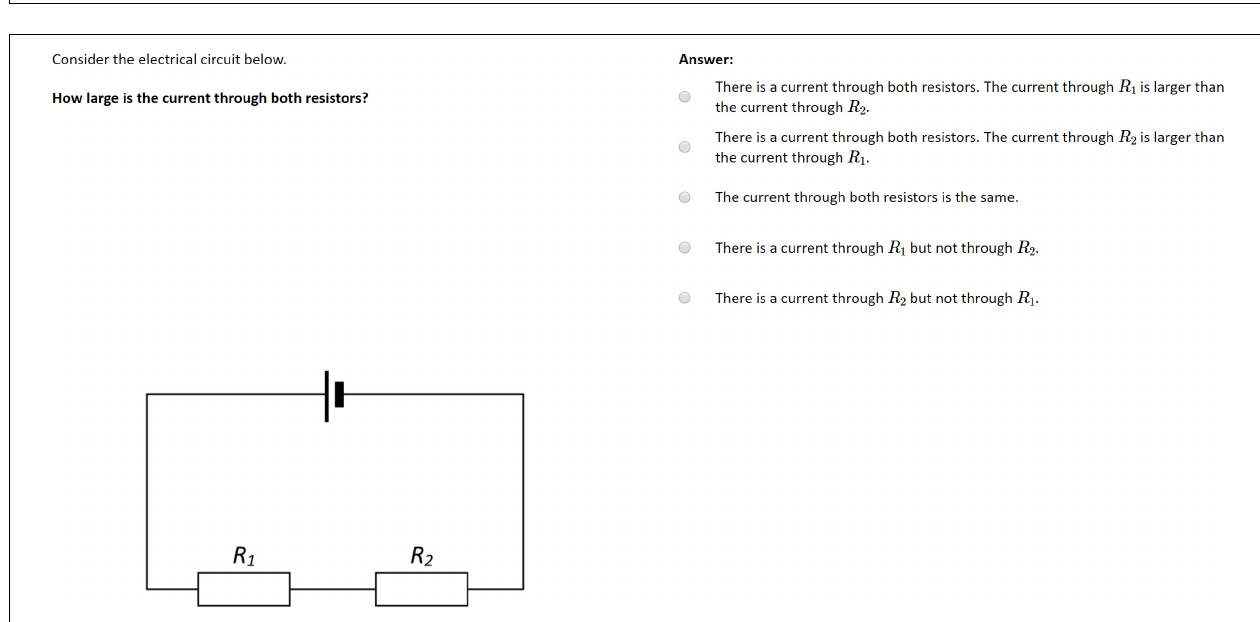
FIGURE 4 | (A) Illustration of the AR view as seen through the HoloLens (the white dotted rectangle indicates the limited field of view), (B) Researcher wearing a HMD.